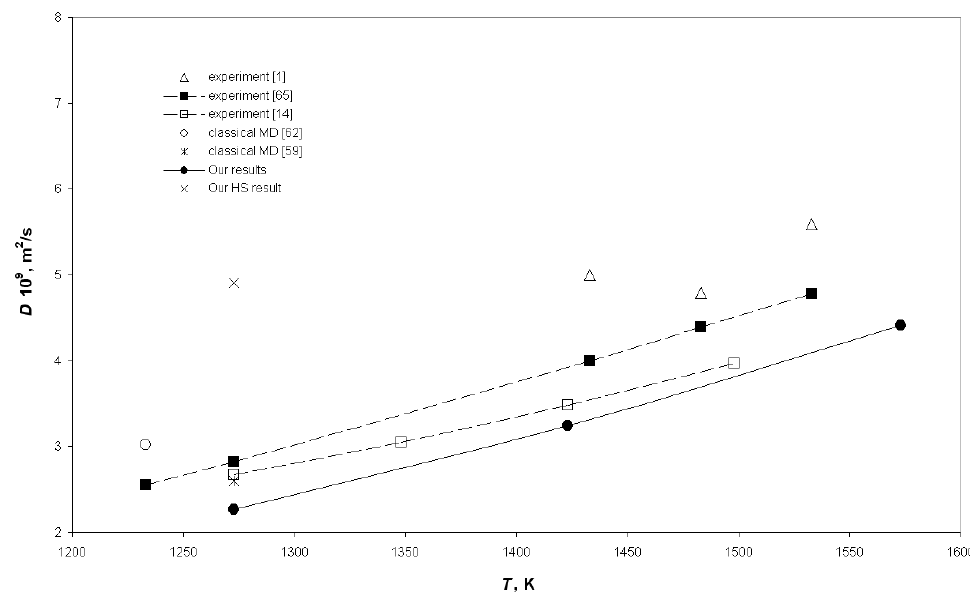
Figure 2. Self-diffusion coefficient of liquid Ag.